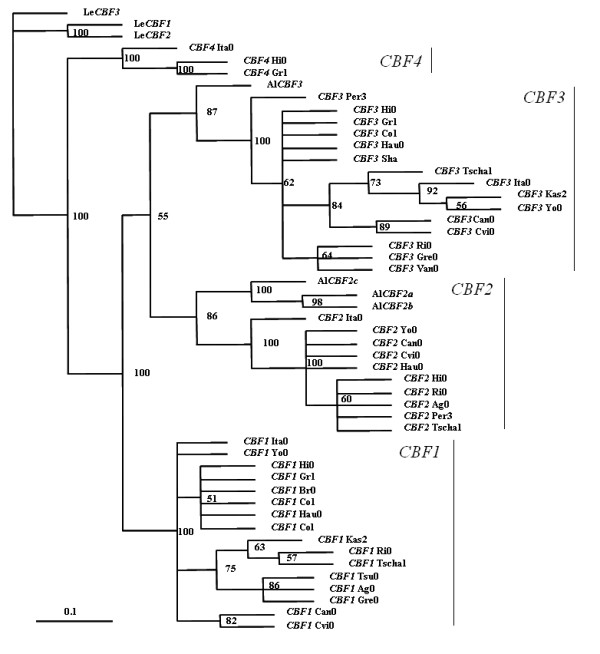
A phylogenetic tree of CBFs. The ecotypes used for phylogenetic tree construction were indicated after each CBF taxon. The scale bar indicates 0.1 substitutions per site. The tree is unrooted. The groups of CBF1, -2, -3, and -4 was indicated by vertical bars.